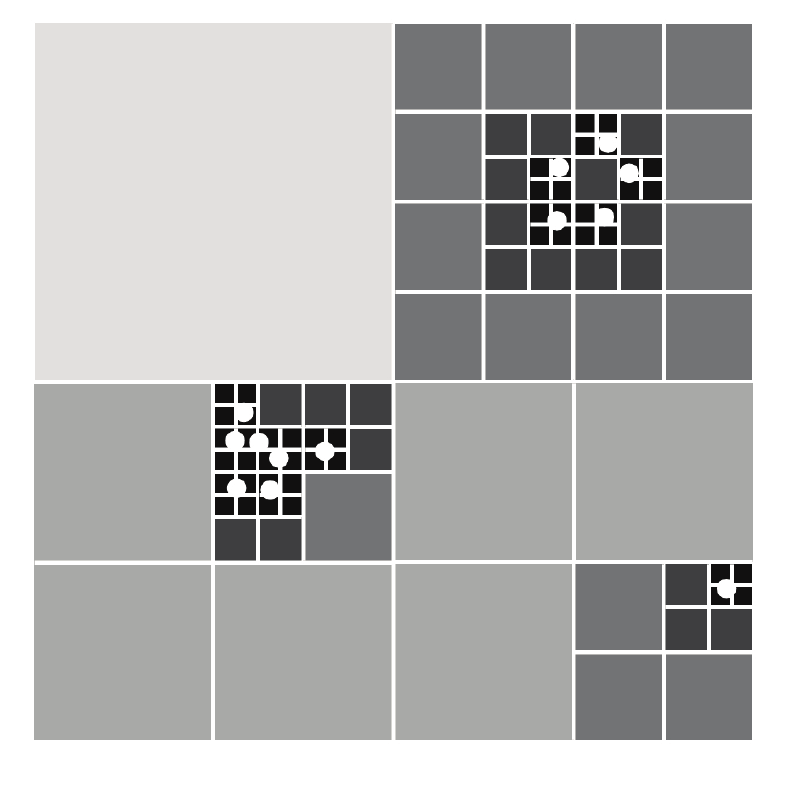
Figure 4. Concept for a raster-based algorithm. The white dots indicate laser